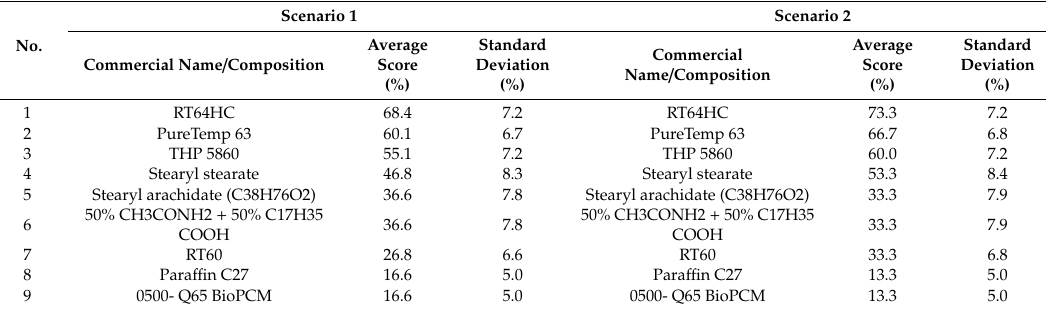
Table 6. Average values obtained by the PCM candidates for the CON